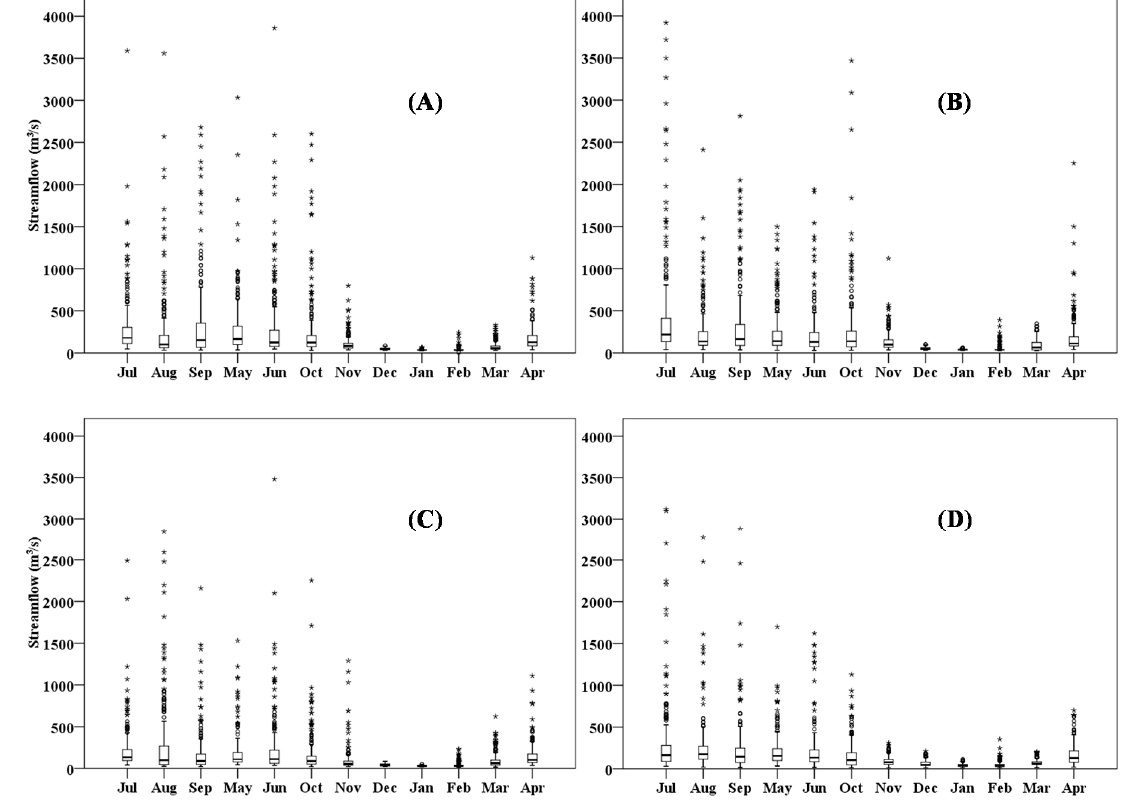
Figure 4. Box plot for the monthly extreme streamflow data in the flood season (July, August, and September), wet season (May, June, and October), and dry season (November–April) in the 1970s ( A ), 1980s ( B ), 1990s ( C ), and 2000s ( D ).